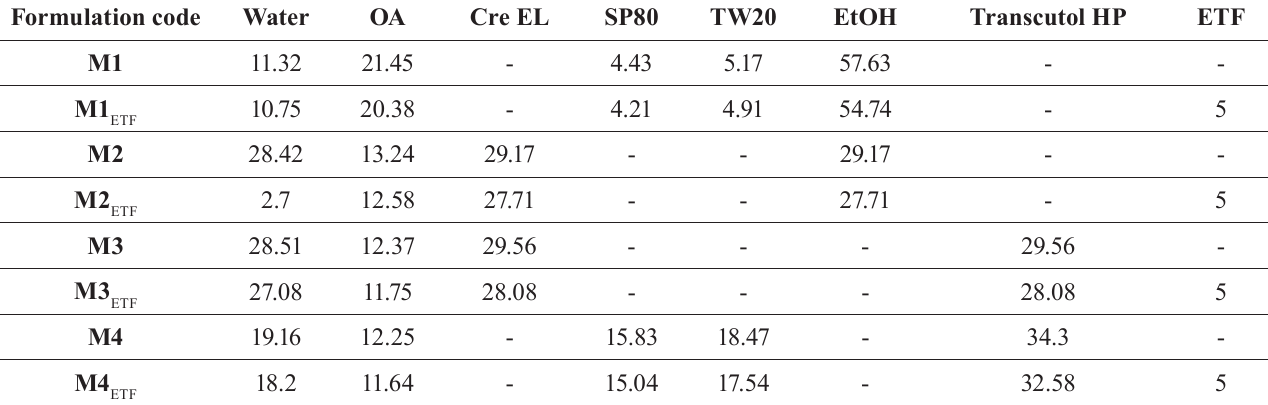
TABLE I - C omposition of ideal microemulsion formulations (%, w/w) Formulation